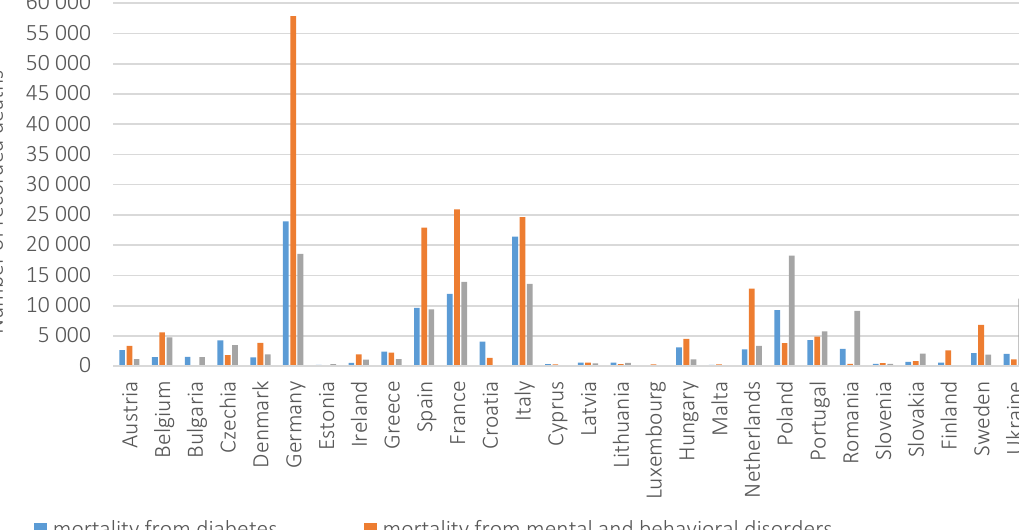
Figure 5. Comparative analysis of the EU countries and Ukraine in terms of housing overcrowding and mortality from viral hepatitis and their consequences in 2019 mortality, and mortality from pneumonia in the EU for 2011–2019 for further stage of research (Eurostat, 2022a). A comparative analysis of Ukraine and EU countries in terms of mortality rates from the above deadly diseases in 2019 is presented in Figure 6.